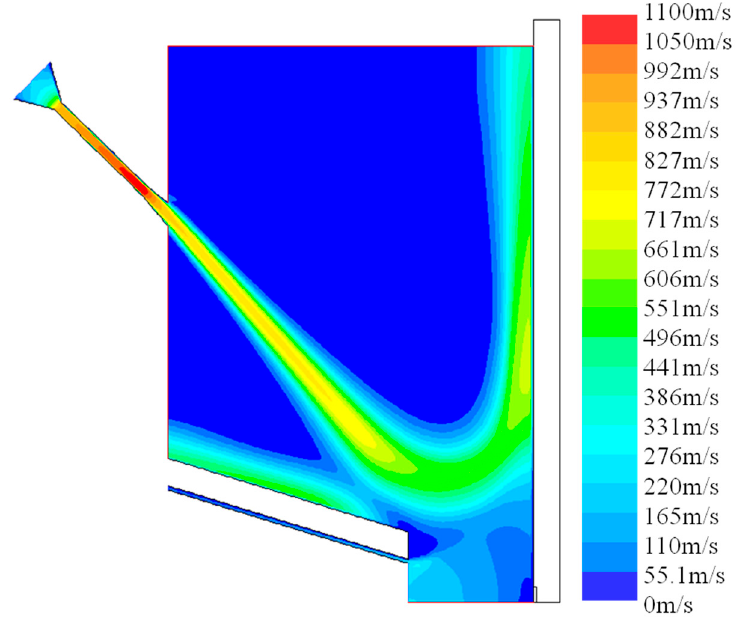
Materials 2020 , 13 , x Figure 8. Cloud diagram of gas flow velocity under optimal parameters. Figure 8. Cloud diagram of gas flow velocity under optimal parameters.